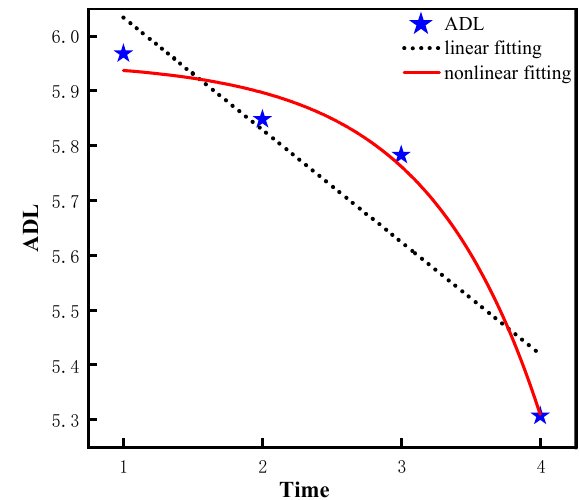
Figure 3. Trajectory of leisure activity of older adults.